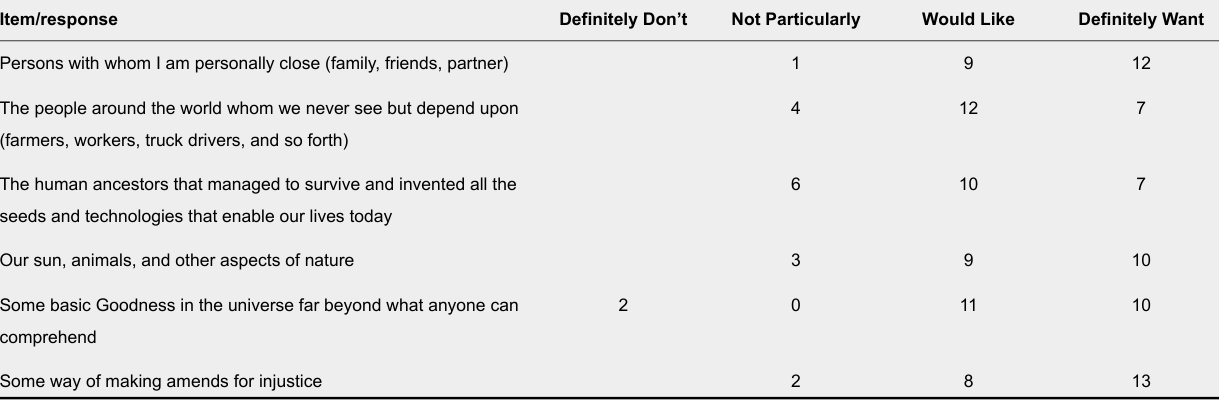
Individual Responses to Possible Items for the Celebration of Global